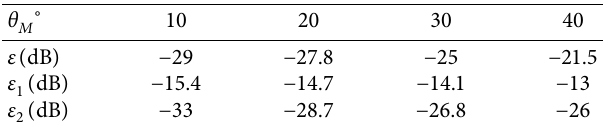
Figure 9: Sum and difference beam under angle scan: (a) θ Table 5: Sum and difference beam parameter comparison when θ changes.